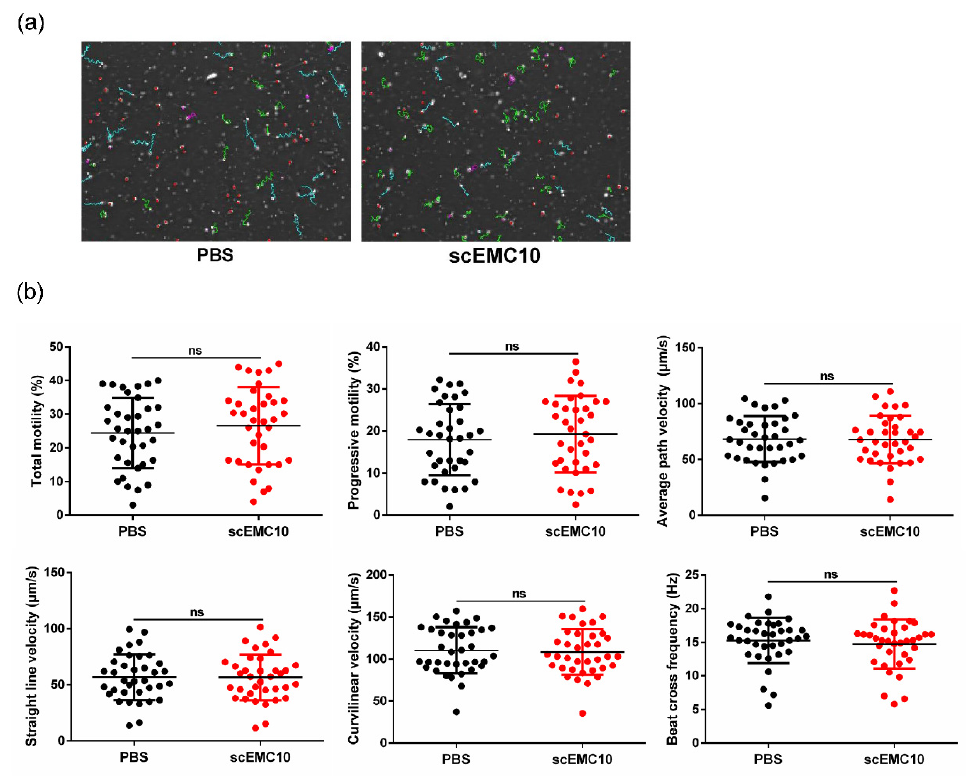
Figure 6. scEMC10 cannot improve sperm motility in humans with asthenozoospermia. ( a ) Representative images of movement trajectories of scEMC10- or PBS-treated spermatozoa under a 10× objective lens. Green trajectories represent the trajectories of rapid-moving spermatozoa. ( b ) Sperm motility analysis of those spermatozoa by computer-assisted sperm analysis. ns, not significant. The sperm samples were incubated with 1 µ g/mL recombinant scEMC10 protein or phosphate-buffered saline (PBS) at 37 ◦ C for 1